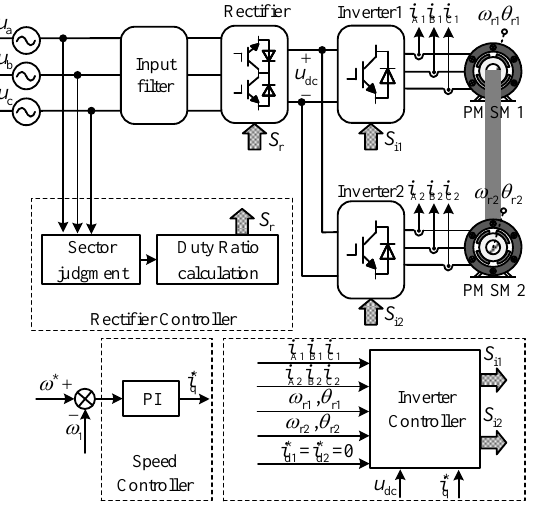
Figure 2. Control structure diagram of the dual-motor system fed by an IMC.